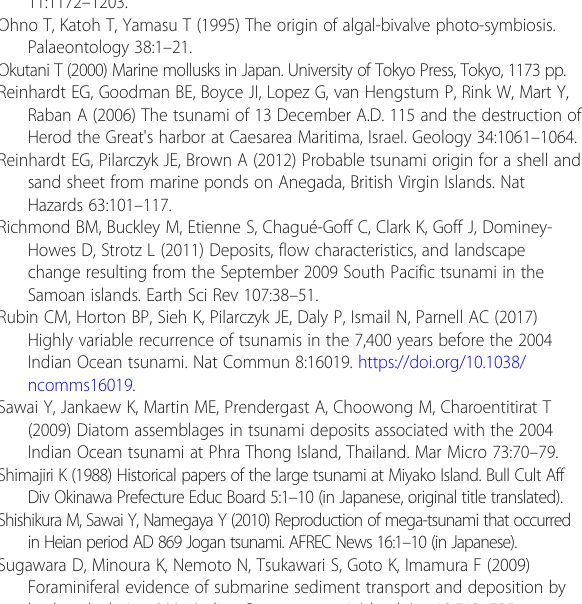
arc: a Holocene stratigraphic record from Chirikof Island, Alaska. Geosphere 11:1172 –